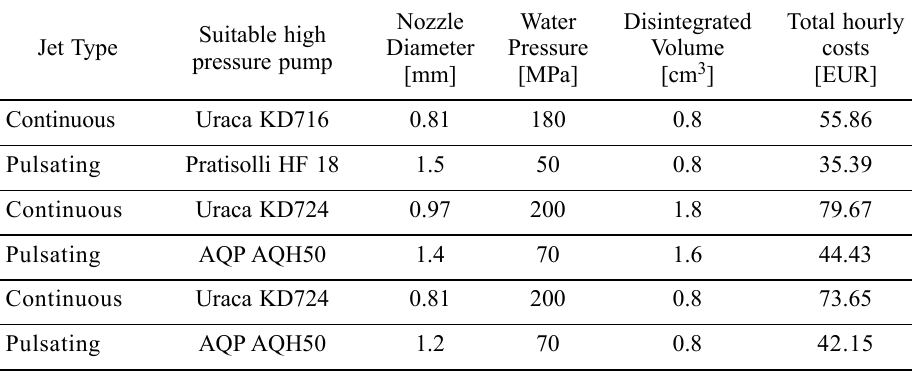
Table 2. Comparison of couples of surfaces treated by continuous oscillating jet generated by high pressure and pulsating oscillating jet generated by lower pressure and total hourly costs for removal of specified volume when using specified pump